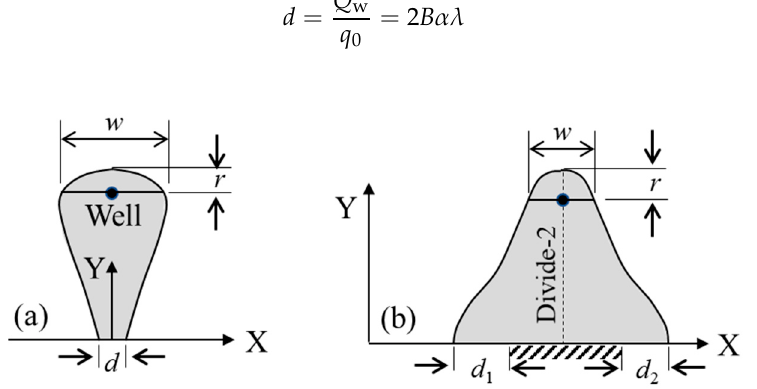
Figure 9. Shape factors of a symmetrical catchment zone: ( a ) type-I; ( b ) type-III.